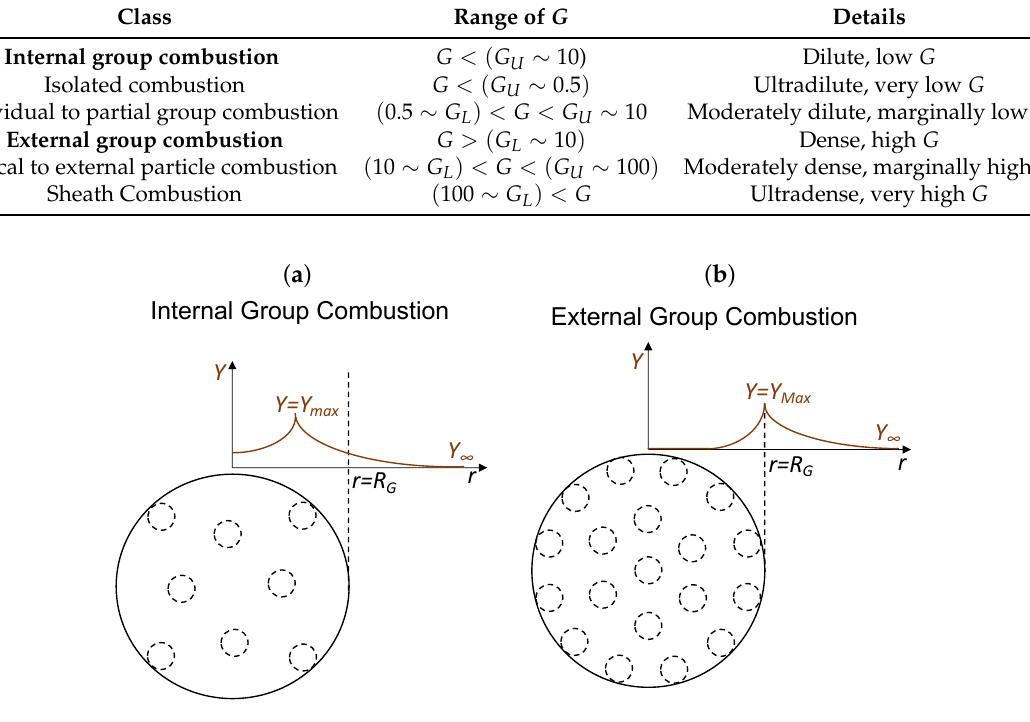
Figure 7. Illustration of major group combustion modes of